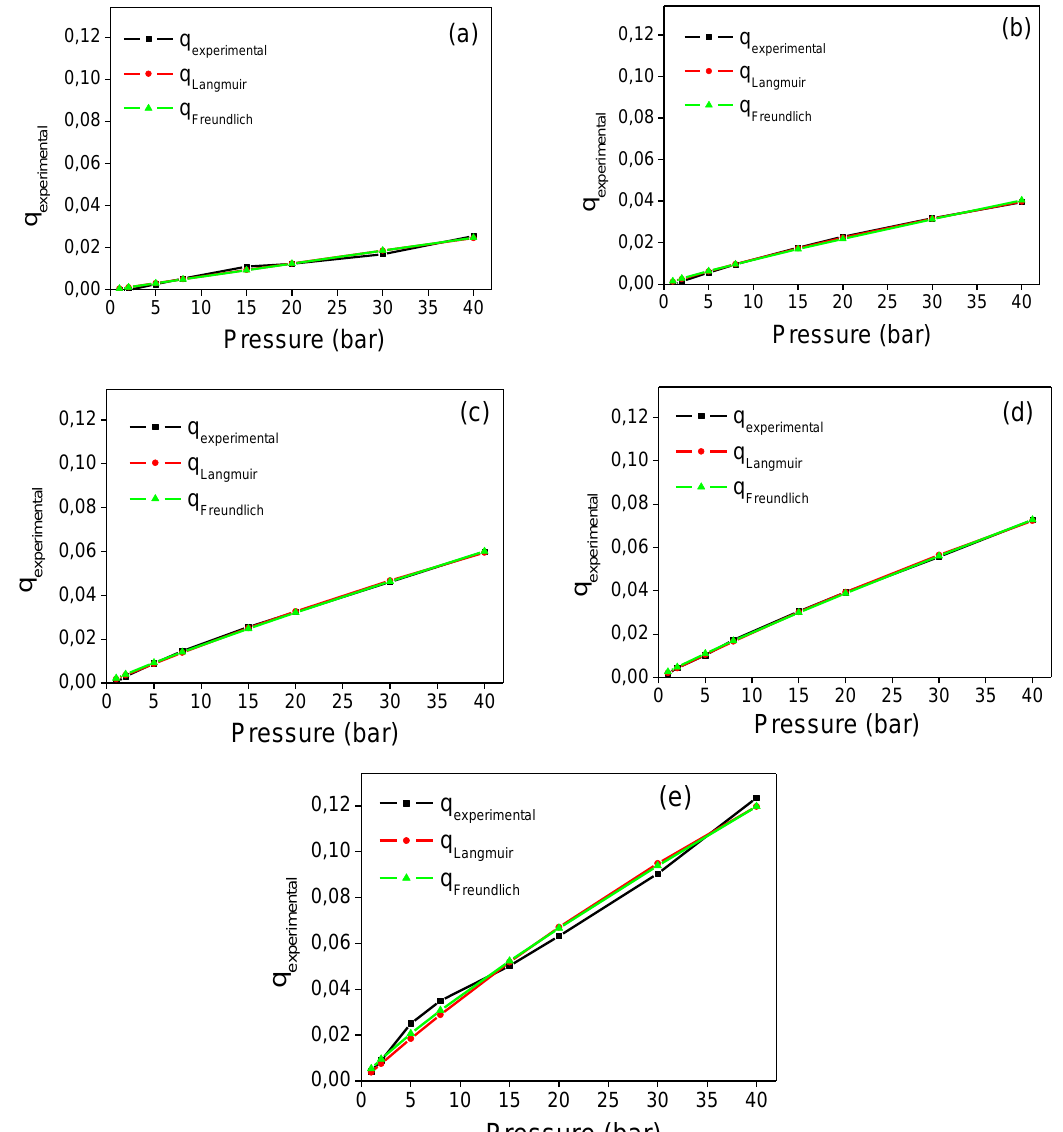
Figure 8. Comparison of isotherms of Langmuir and Freundlich Si12 ( a ) Si25 ( b ) Si36 ( c ) Si50 ( d ) and SiCO 2 ( e